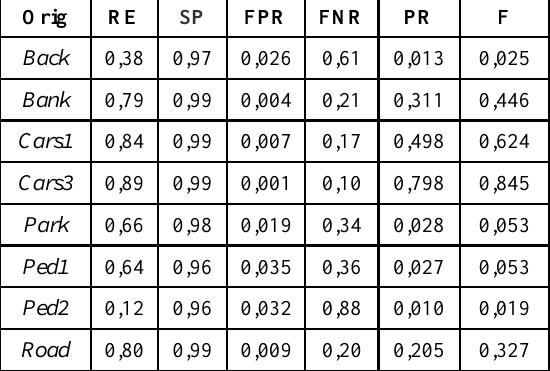
Table 2. Original algorithm results for each video in terms of